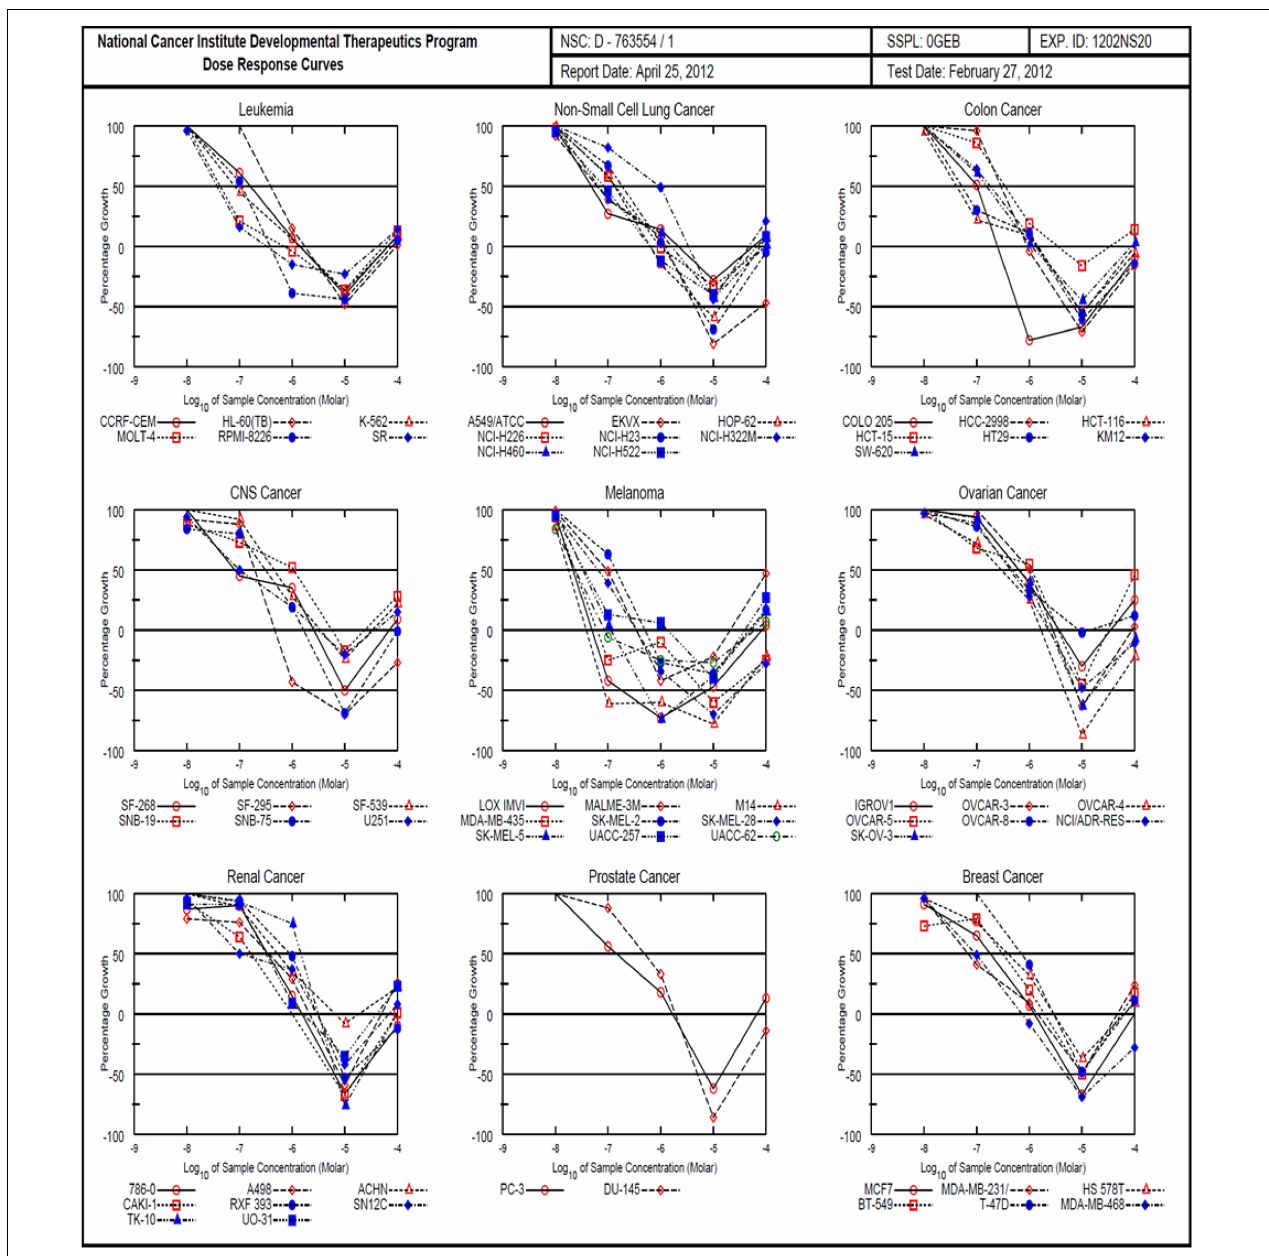
FIGURE 4 | Comparison of NCI-60 cell panel for monanchocidin A. Differential toxicity of monanchocidin A toward NCI 60 cancer cell lines: Growth inhibition of NCI 60 cancer cell lines after exposure to compound 1. The cell lines were plated 24 h prior to adding the compound and then incubated for additional 48 h. The cell numbers were then estimated using Sulforhodamine B as